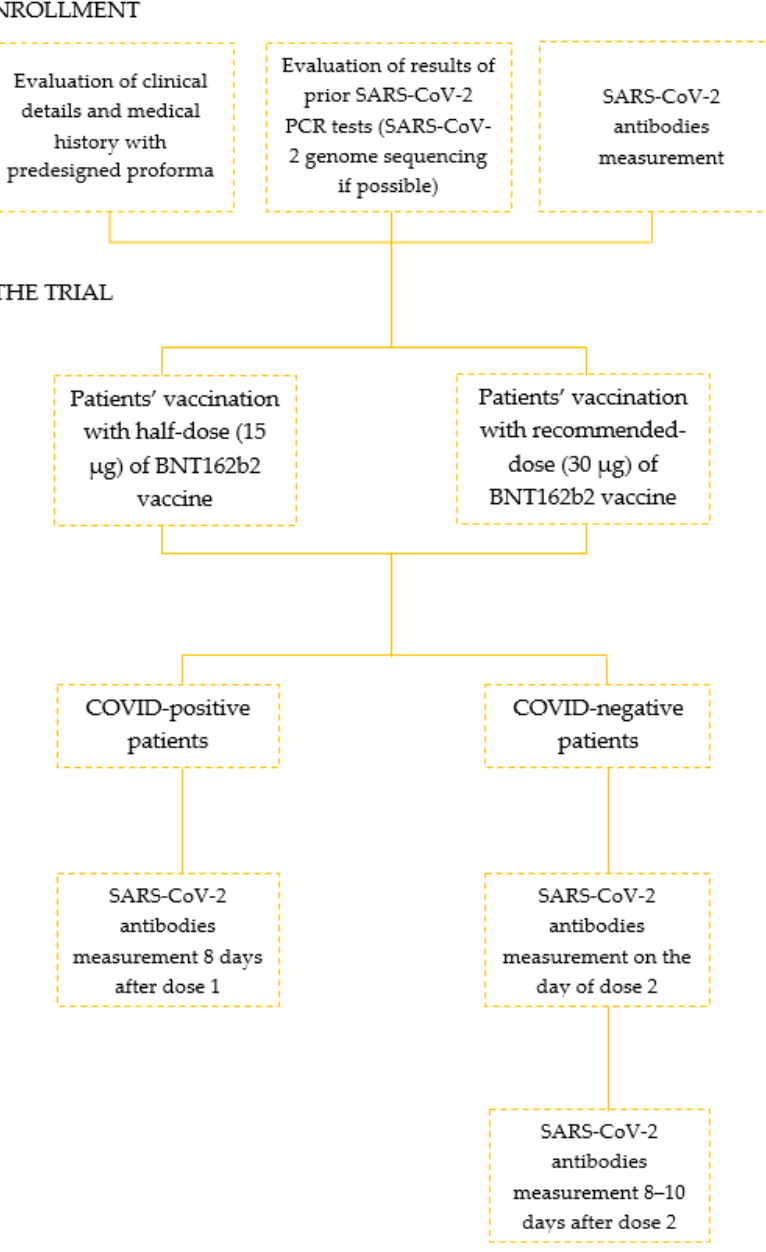
Figure 1. The flow-chart of patients’ recruitment and study